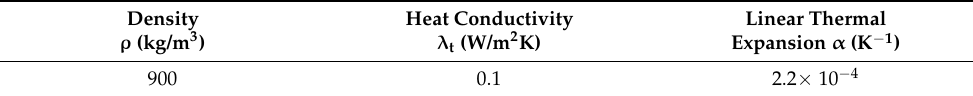
Table 6. Physical properties of ABS—plastics and layer d = 0.19